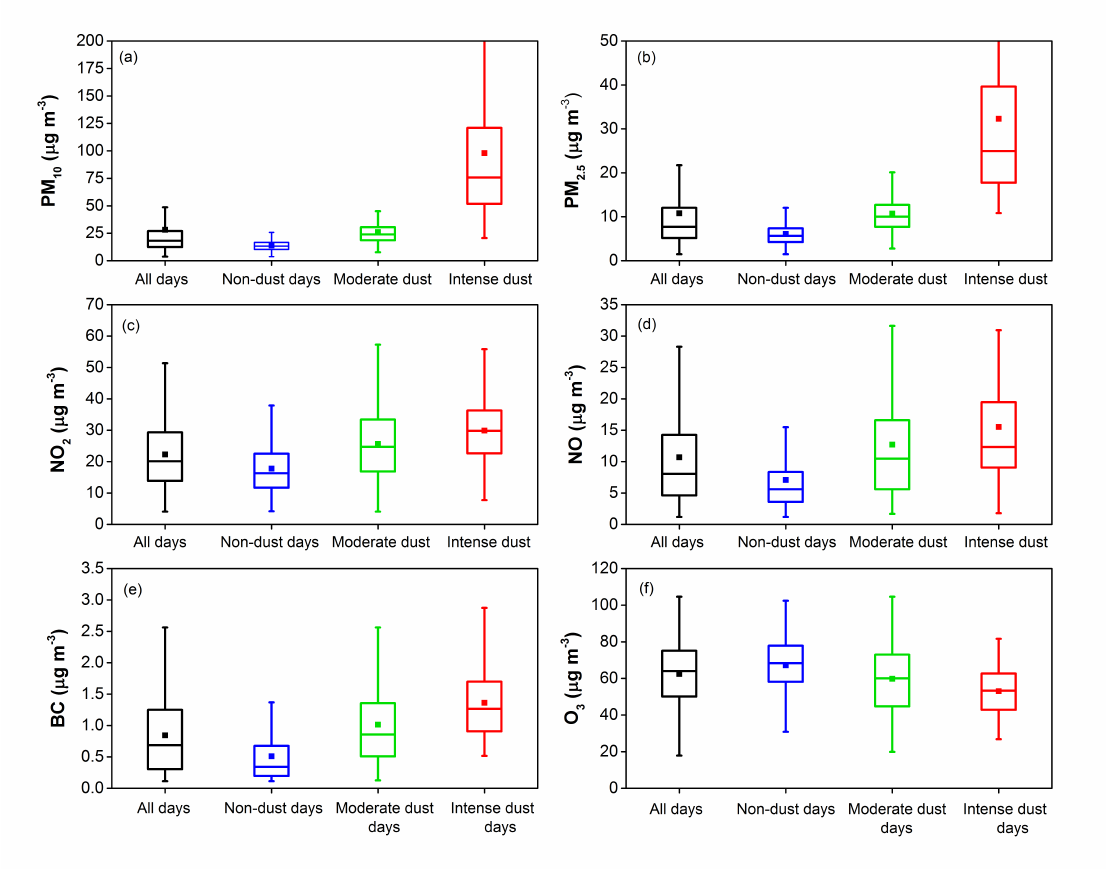
Figure 7. Mean (24-h) concentrations of ( a ) PM 10 ; ( b ) PM 2.5 ; ( c ) NO 2 ; ( d ) NO; ( e ) Black Carbon (BC) ≤ 10 µ m, and f) O 3 calculated for all days, non-dust outbreak days, and different intensities of dust outbreaks during winter (December–March): The horizontal lines and the squares within the box represent the median and mean values, respectively, while the bottom and top of each box are the 25th and 75th percentiles. The whiskers are the 5th and 95th percentiles. All data are for the 2012 to 2017 period except for black carbon data, which are for